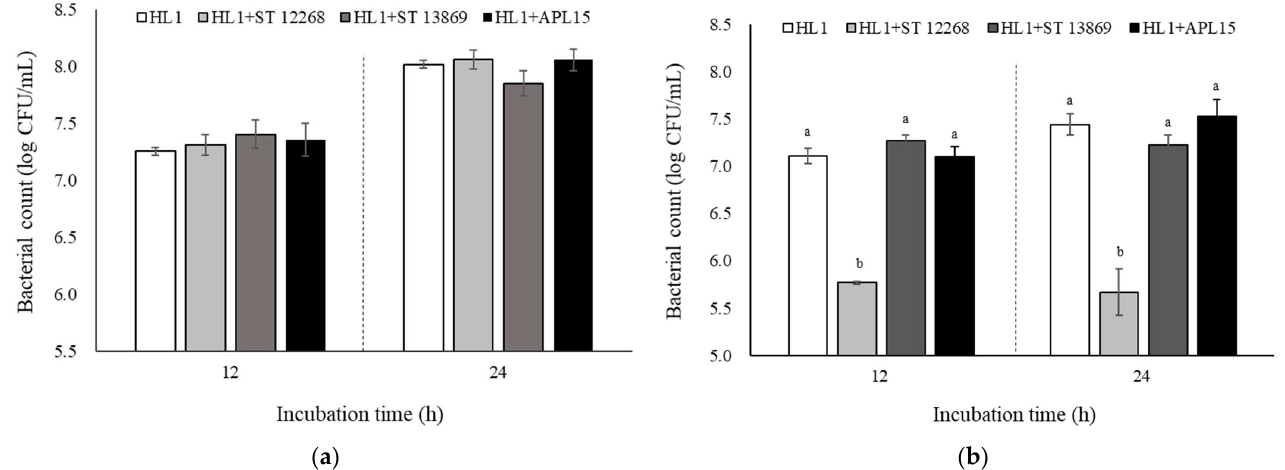
Figure 2. Effect of HL1 co-culturing with each selected strain on HL1 bacterial counts in MRS broth ( a ) and skimmed milk ( b ) at 30 °C for 12 and 24 h. Data are given as mean ± SD ( n = 3). a,b Mean values without the common letter within the same incubation time indicate a significant difference ( p < 0.05). Abbreviations: HL1, L. kefiranofaciens HL1; ST 12268, S. thermophilus BCRC 12268; ST 13869, S. thermophilus BCRC 13869 T ; APL15, Lc. lactis subsp. cremoris APL15.